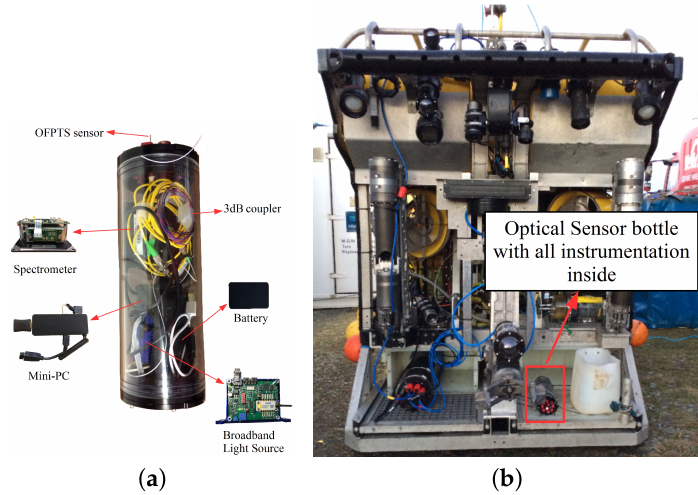
Figure 4. ( a ) Marinised bottle with all instrumentation inside; ( b ) Marinised bottle mounted on the Remote Operated Vehicle (ROV)